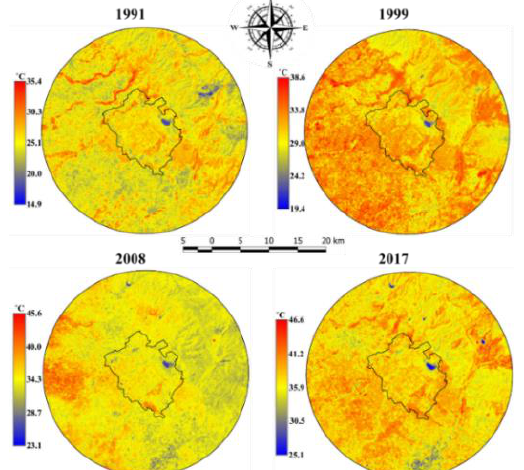
Figure 7: Temporal Land Surface temperature analysis for Chandigarh with 10km buffer